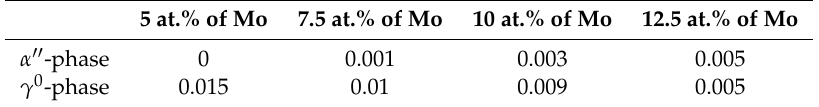
Table 1. Computed energies (in eV/atom) of the α (cid:48)(cid:48) -phase and γ 0 -phase (for various Mo concentrations) at T = 0 K. All values are given with respect to the energy of the α -phase. 5 at.% of Mo 7.5 at.% of Mo 10 at.% of Mo 12.5 at.% of Mo α (cid:48)(cid:48) -phase 0 0.001 0.003 0.005 0.005